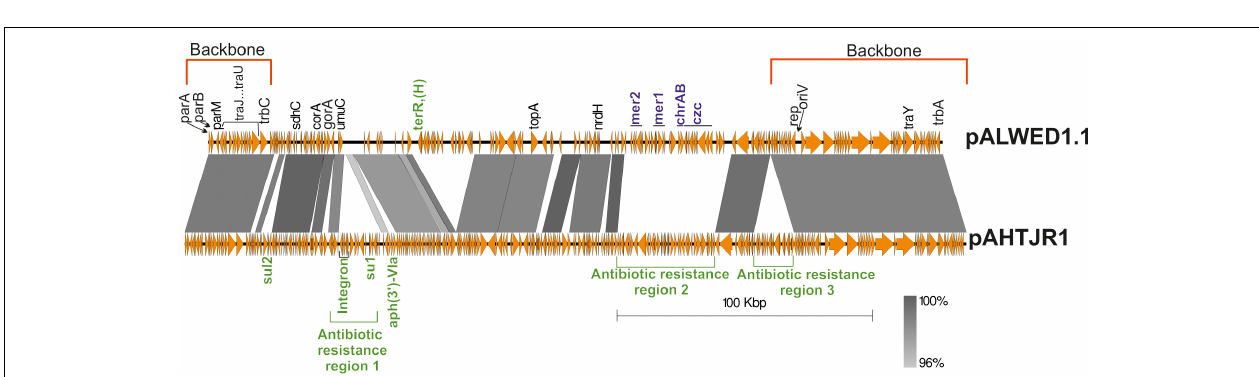
FIGURE 2 | Iteron-controlled putative replicon of pALWED1.1. (A) The relative location of the replication initiator gene and the iterons. Pink arrow indicate the rep gene, little black arrows indicate surrounding repeat sequences (iterons). (B) Consensus sequence of the iterons of pALWED1.1.